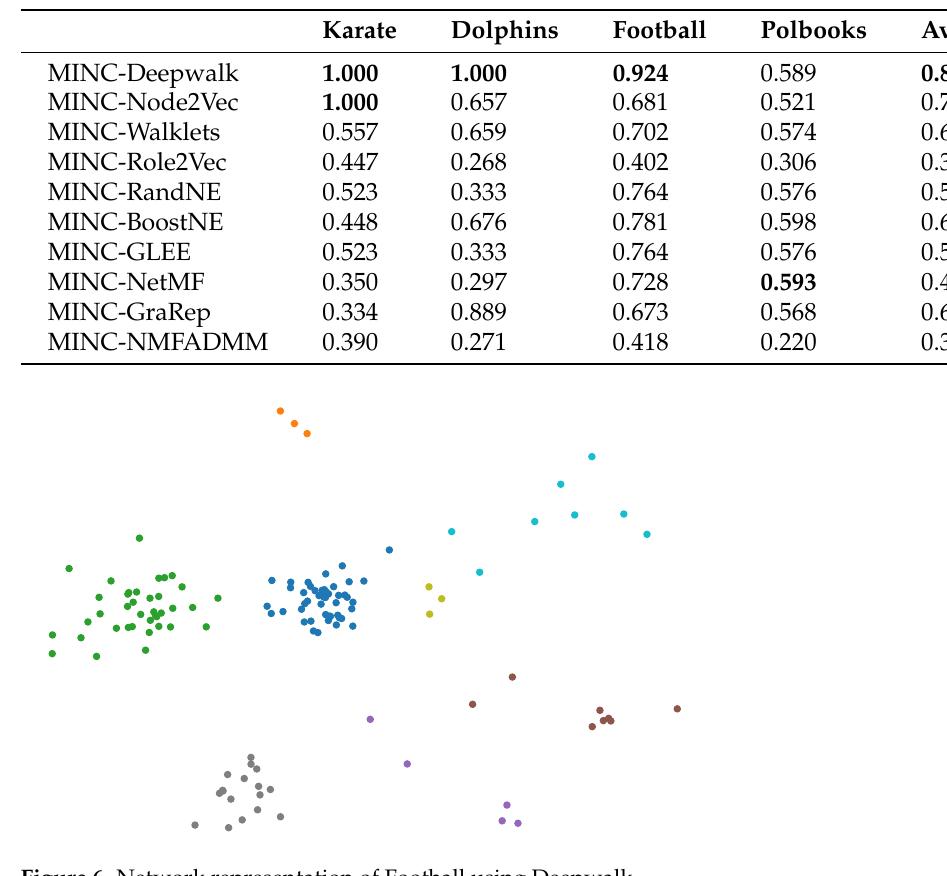
Figure 6. Network representation of Football using Deepwalk.